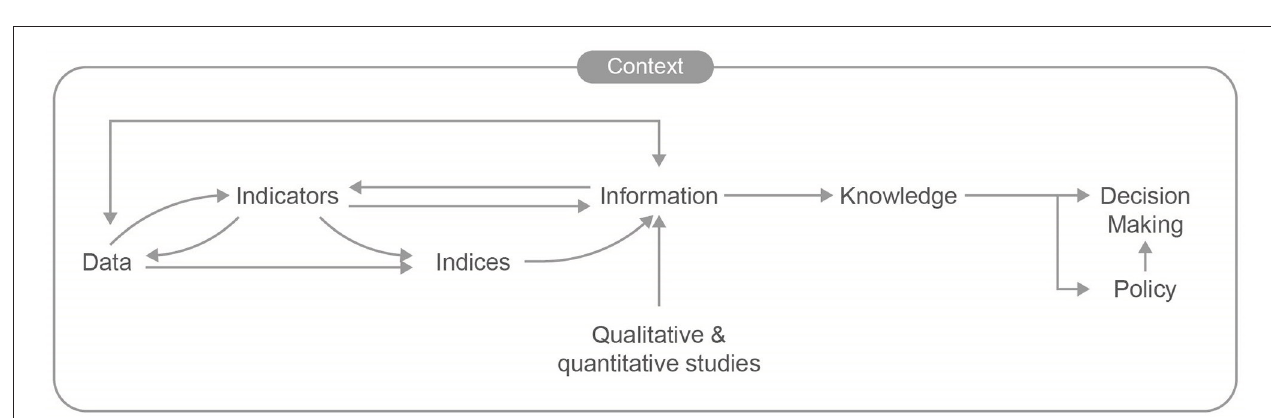
FIGURE 2 | From data to decision making; modified from Segnestam (2002) and Waas et al. (2014).